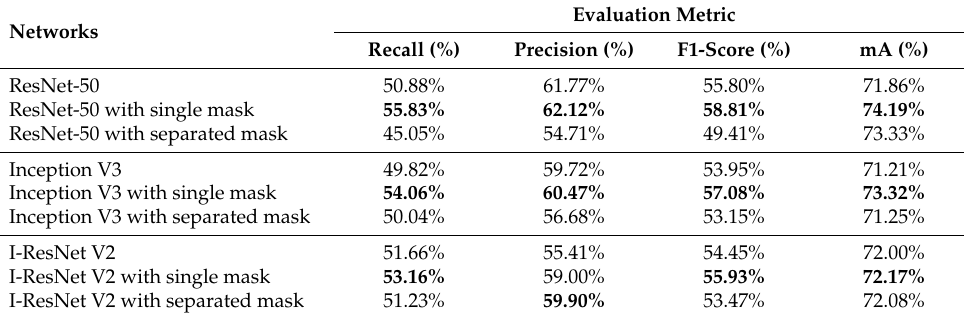
Table 4. Ablation study for the proposed method on RAP